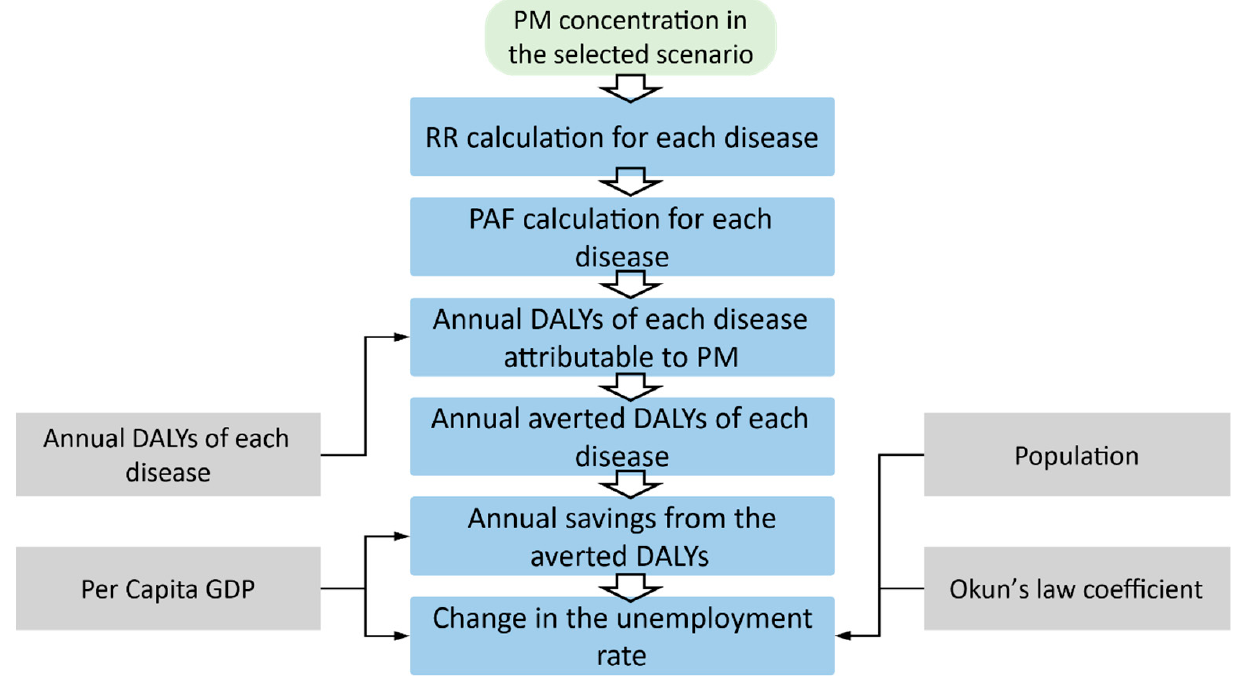
Figure 5. Calculation flow in health–economic benefits assessment (Created by the authors).